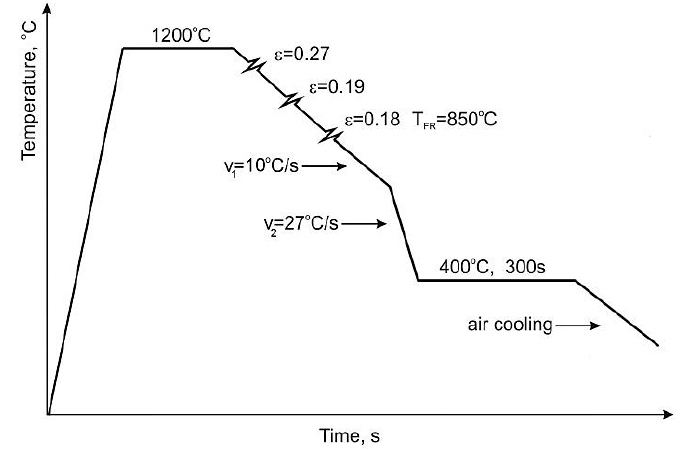
Figure 1. Parameters of thermomechanical processing of the investigated steel ( T FR —temperature of finishing rolling). Table 2. Conditions of the thermomechanical rolling.